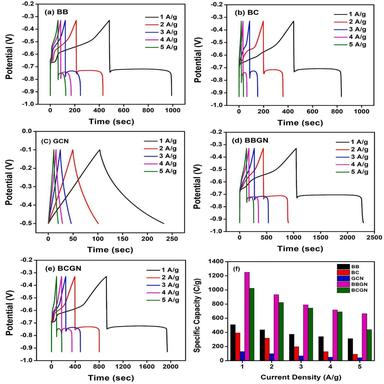
(a–e) GCD profiles at different current densities and (f) specific capacity as a function of current density for BB, BC, GCN, BBGN, BCGN electrodes.